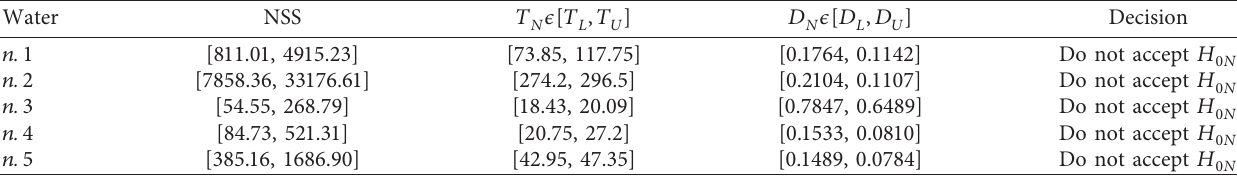
Table 3: The values of NSS of five